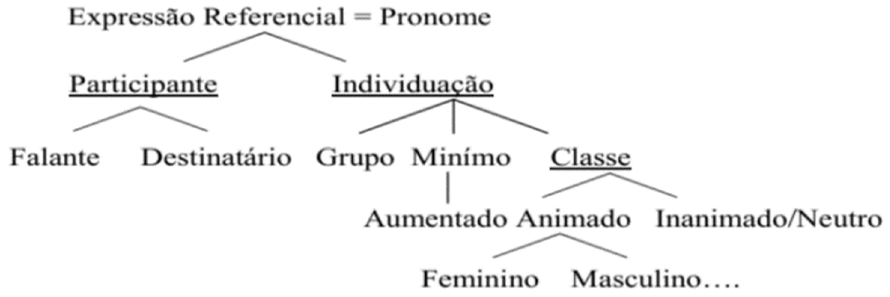
Figure 1. Adapted from Fernanda de Oliveira Cerqueira (2015) 9 .